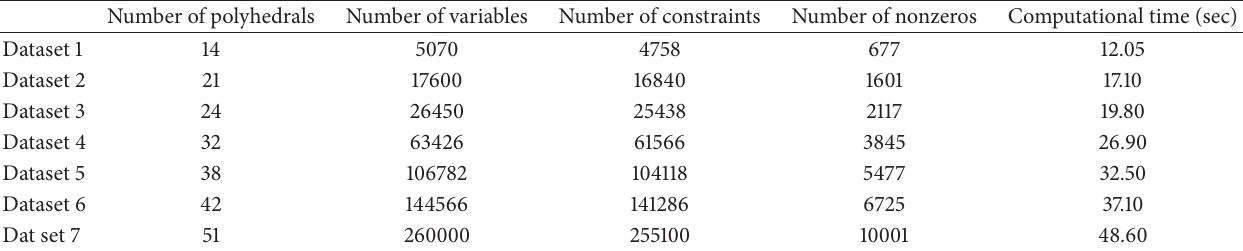
Table 1: Sizes and computational results for some MMNs with |𝐾| = 1 ( 𝑇 = 13, 20, 23, 31, 37, 41, 50